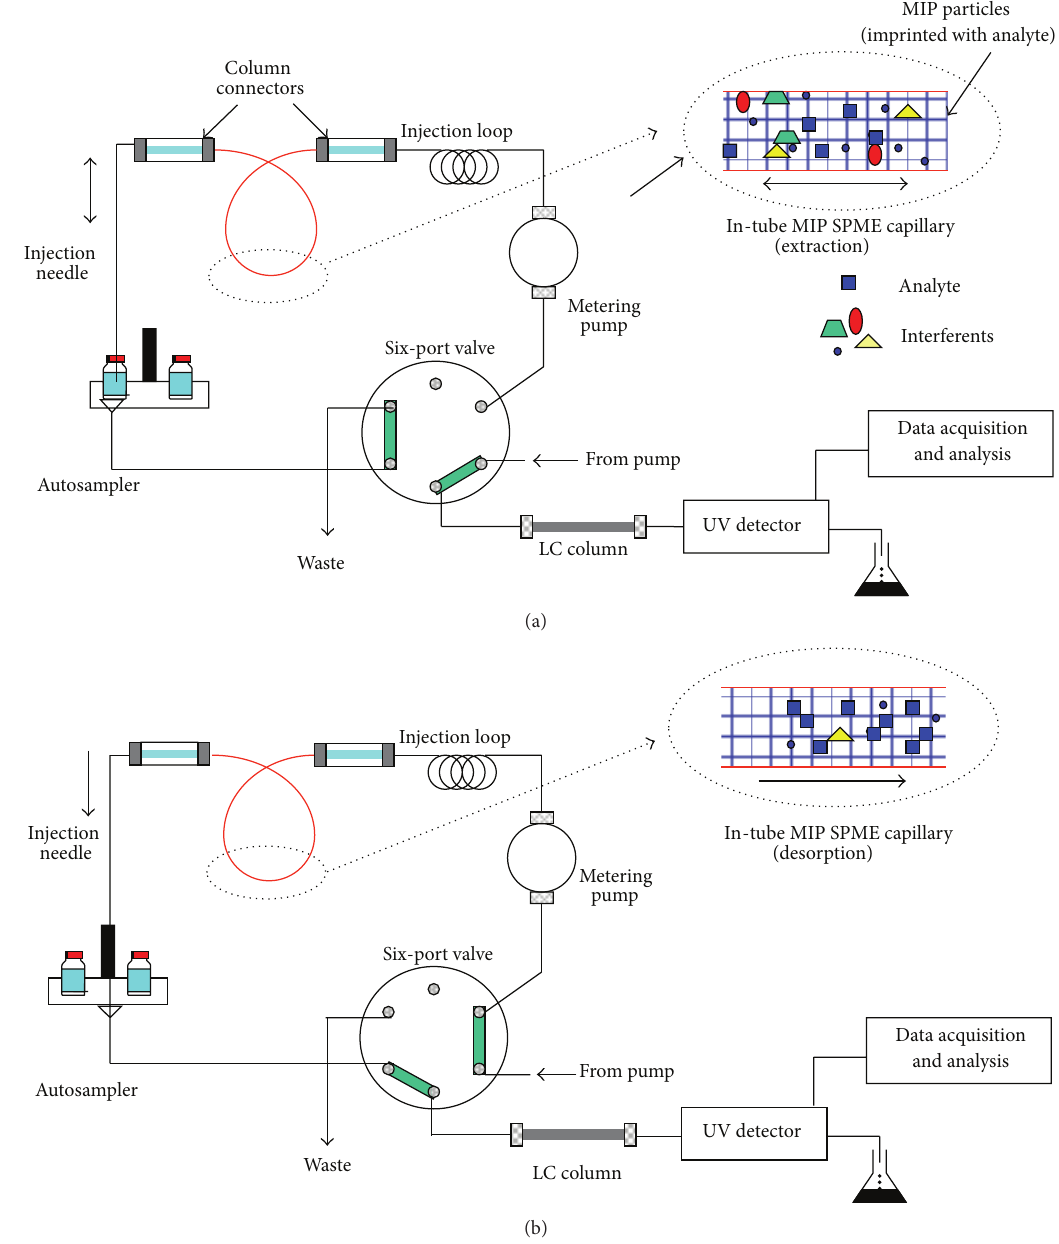
Figure 8: Schematic representation of in-tube MIP SPME configuration. (a) Load position (extraction); (b) injection position (desorption)